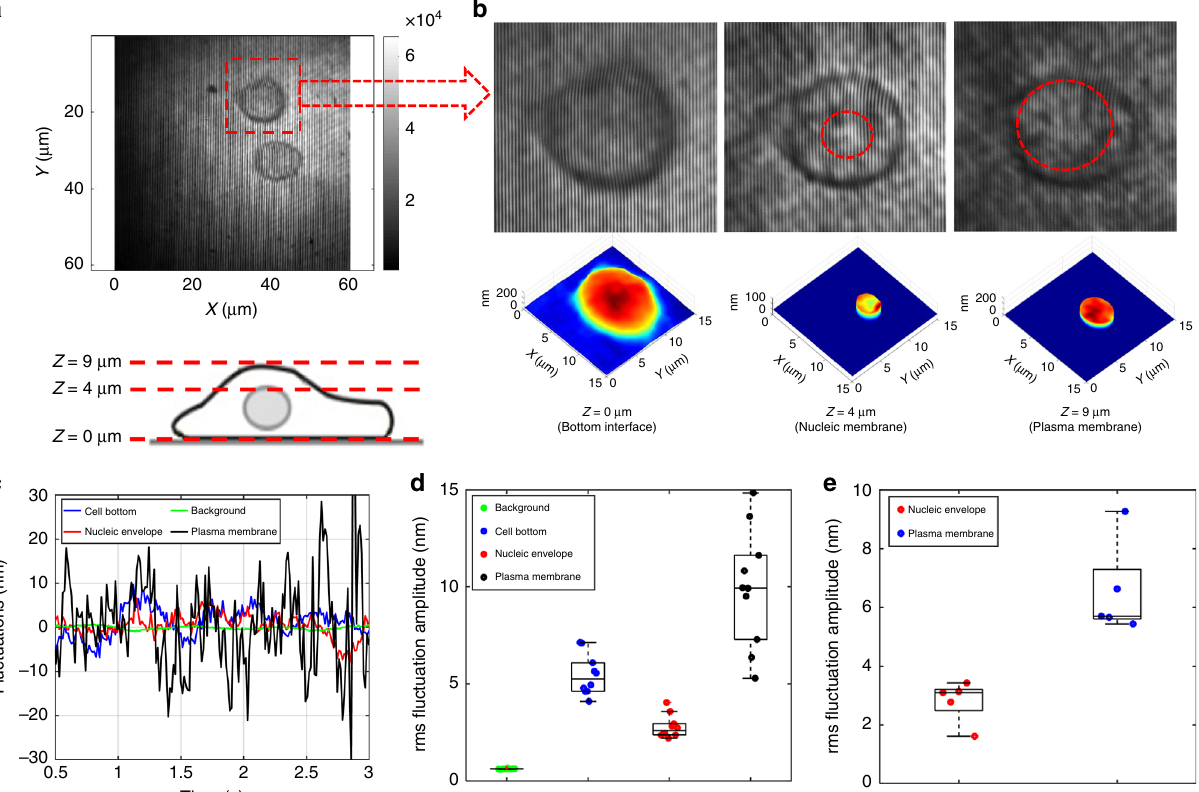
Fig. 2 Nucleic envelope and plasma membrane fl uctuations in embryonic stem cells. a Interferogram recorded at the cell – dish interface ( Z = 0 μ m). Bottom cartoon shows three axial positions, cell – dish interface, nucleic envelope, and plasma membrane, where interferograms are recorded. b The upper row shows the zoomed interferogram at the corresponding axial positions, the red circles mark the nucleic envelope and plasma membrane. The bottom row shows the 3D height map reconstructed from the corresponding interferograms. Nucleic envelope and plasma membrane are masked in the 3D plot. c Amplitude of membrane fl uctuations for background (outside cell region), cell bottom, nucleic envelope, and plasma membrane. d rms fl uctuation amplitude for different spatial locations of corresponding interface of selected stem cell. The line within each box represents the median, and the lower and upper boundaries of the box indicate the fi rst and third quartiles, respectively. Error bars (whiskers) represent the interquartile range ( n = 10). e Plot of the rms fl uctuation amplitude of nucleic envelope and plasma membrane for different embryonic stem cells. The line within each box represents the median, and the lower and upper boundaries of the box indicate the fi rst and third quartiles, respectively. Error bars (whiskers) represent the